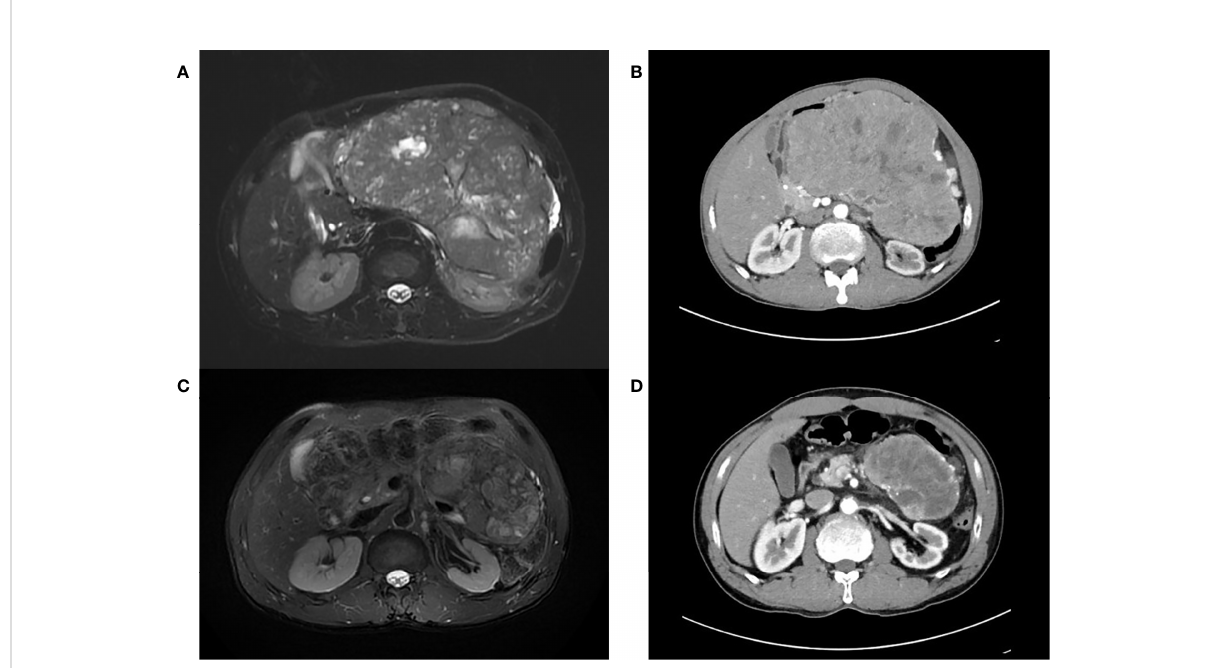
FIGURE 1 (A) Pretreatment magnetic resonance imaging (MRI) image depicting a multilobulated tumor with the size of 16.1 cm × 14.9 cm × 14.5 cm in the left upper abdomen. (B) Tumor progression up to the greatest diameter of 18 cm in the axial view of computerized tomography (CT) scans after treatment of Lanreotide. (C) Prominent tumor shrinkage after concurrent chemoradiation. (D) At least 50% reduction of tumor axial perpendicular diameters in preoperative